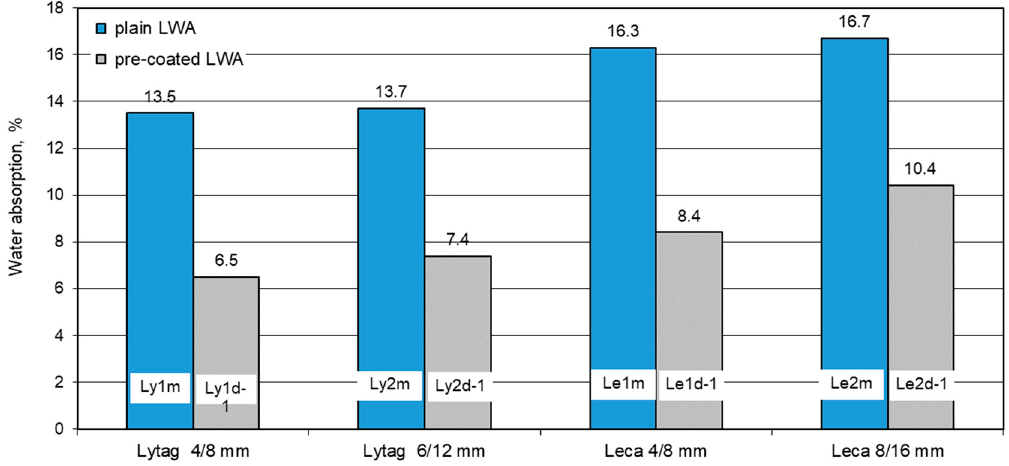
Figure 13. Mean water absorption of concretes with plain and pre-coated lightweight aggregates.